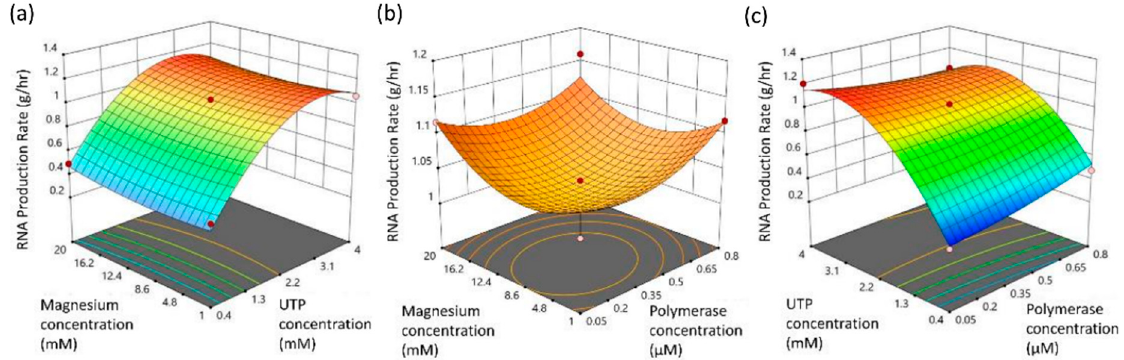
Figure 6. Surface response plots of biomass RNA IVT production rate against factorial concentration projections: ( a ) magnesium and UTP; ( b ) magnesium and polymerase; ( c ) UTP and polymerase.